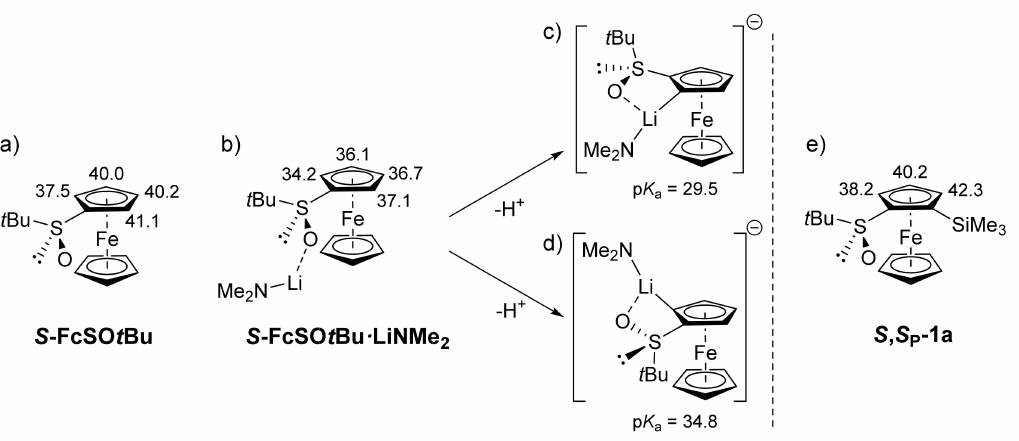
Figure 2. Selected calculated p K a values of ( a ) S -FcSO t Bu , ( b ) its complex with LiNMe 2 , and ( c , d ) the corresponding anions; ( e ) selected calculated p K a values of S , S P -1a